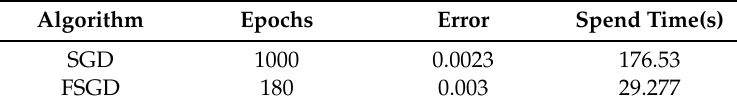
Table 1. Results of contrast experiment.